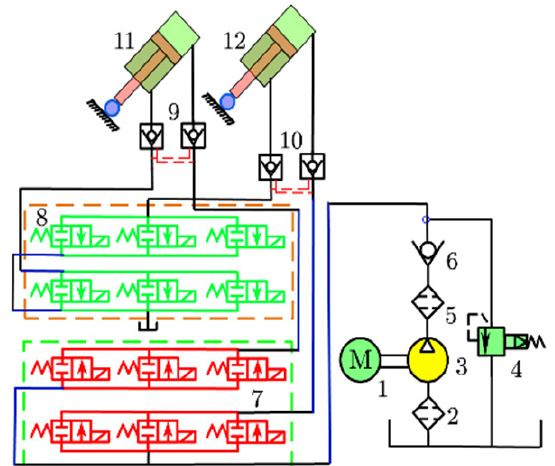
Figure 5. Optimized structure of new hydraulic system of the coal gangue conveying equipment.